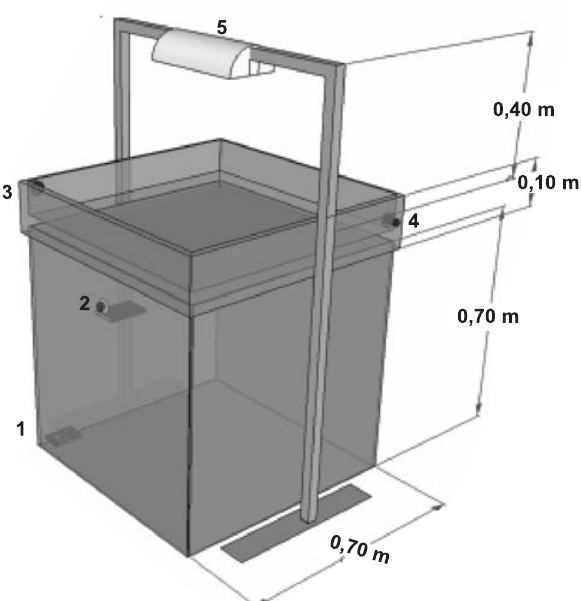
Figura 1. Representação esquemática da câmara usada na marcação das plantas. 1. Microcircula- dores de ar; 2. Septo de borracha na lateral da câmara, para adição do ácido; 3 e 4. Entrada e saída de água; 5. Haste com lâmpada